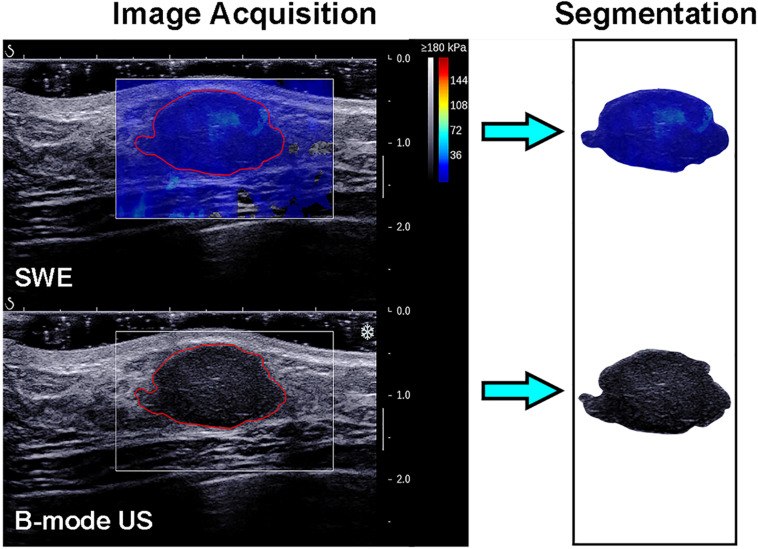
Images show a fibroadenoma in a 41-year-old woman. Top left: The shear-wave elastography (SWE) image shows a homogeneous mass, the region of interest encompassing the whole mass, and the contour line located in the border of the mass. Bottom left: B-mode ultrasonography (US) image shows an irregular hypoechoic mass considered to be a Breast Imaging Reporting and Data System category 3 lesion, and the region of interest encompassed the hypoechoic region which represented the tumor. The segmented SWE image (top right in black box) and B-mode US image (bottom right in black box) were used for further deep learning-based radiomic feature extraction.